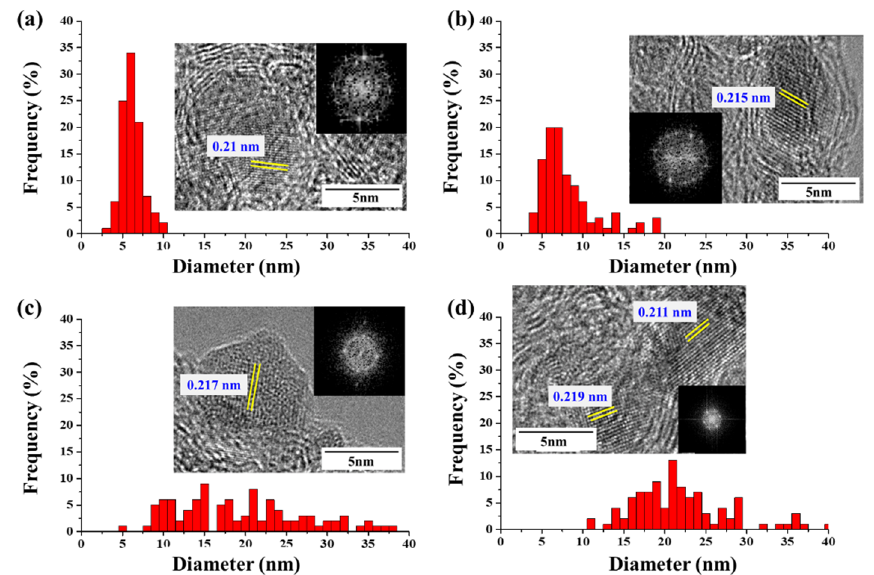
Figure 3. TEM images and size distribution of catalyst particles at CNT bundles with different catalyst precursors: ( a ) ferrocene, ( b ) acetylferrocene, ( c ) ferrocenemethanol, and ( d ) 1,1′-diace- tylferrocene.